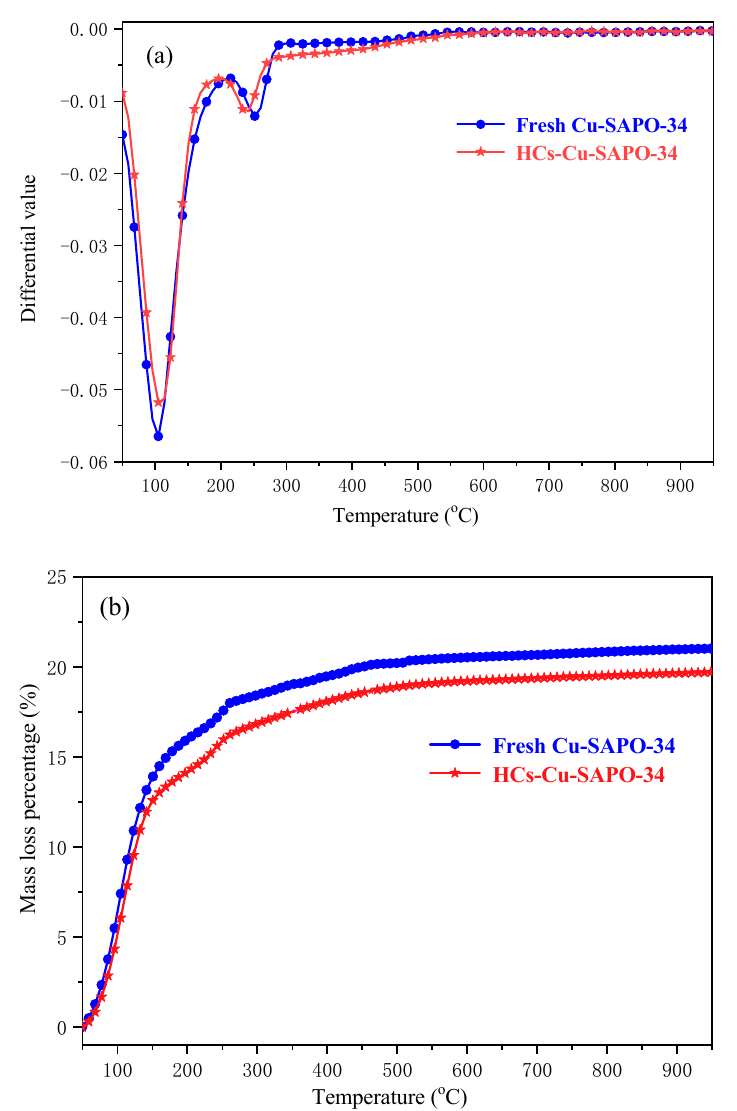
Figure 2. ( a ) the differential profiles and ( b ) mass loss profiles of fresh Cu-SAPO-34 and HCs-Cu- SAPO-34 samples.